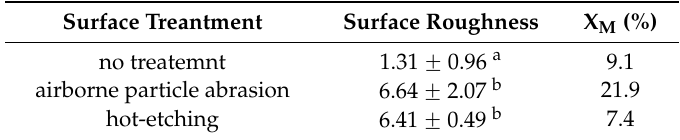
Table 1. Surface roughness (Ra, nm) and X M of zirconia with different surface treatments.